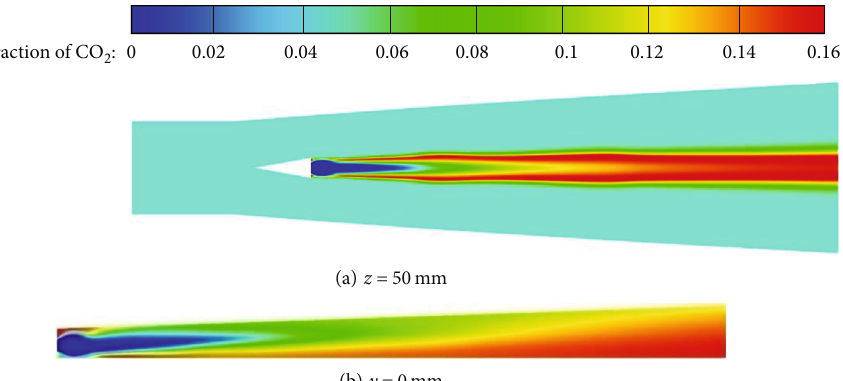
Figure 22: Distribution of mass fraction of CO